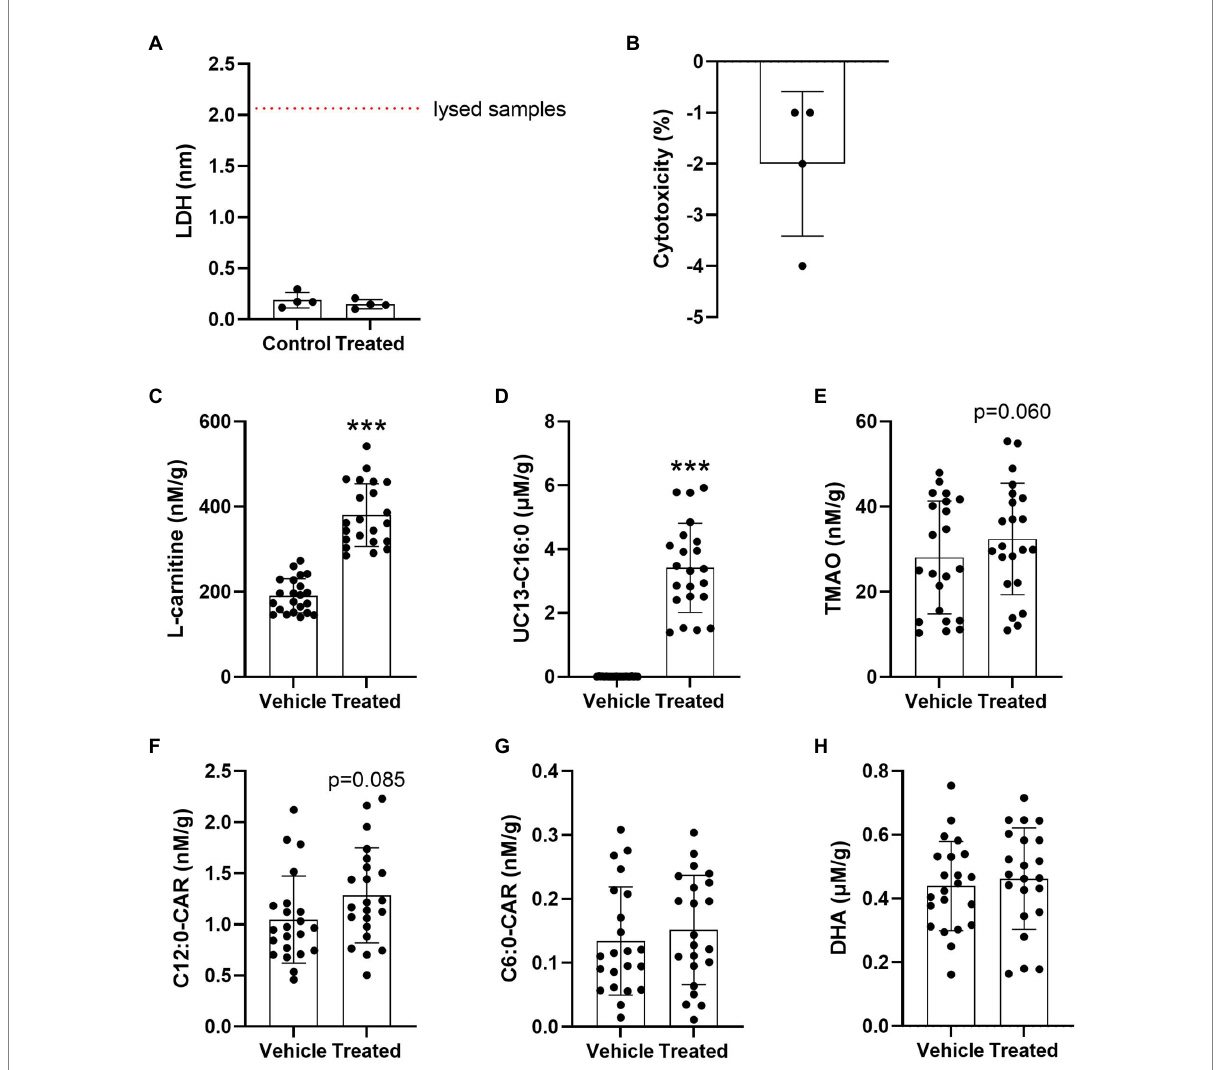
FIGURE 7 Significant cerebrovascular uptake of treatment compounds. (A) Scatterplots with bar showing mean LDH absorbance values in nm in vehicle treated and compound treated cerebrovascular fractions. (B) Scatterplots with bar showing % treatment cytotoxicity ± SD. (C) Scatterplots with bar showing mean concentration of L-carnitine in nM per gram of protein ± SD in vehicle treated and compound treated cerebrovasculature. (D) Scatterplots with bar showing mean concentration of UC13-C16:0 in μ M per gram of protein ± SD in vehicle treated and compound treated cerebrovasculature. (E) Scatterplots with bar showing mean concentration of TMAO in nM per gram of protein ± SD in vehicle treated and compound treated cerebrovasculature. (F) Scatterplots with bar showing mean concentration of C12:0-CAR in nM per gram of protein ± SD in vehicle treated and compound treated cerebrovasculature. (G) Scatterplots with bar showing mean concentration of C6:0-CAR in nM per gram of protein ± SD in vehicle treated and compound treated cerebrovasculature. (H) Scatterplots with bar showing mean concentration of DHA in μ M per gram of protein ± SD in vehicle treated and compound treated cerebrovasculature. Statistics: related-samples analysis, *** p < 0.001. Numbers per group: matched control-treated cerebrovascular sample pairs n = 4 per group for LDH test. Matched control-treated cerebrovascular sample pair n = 22 per group for the uptake study. Cx:y-CAR, acylcarnitines; DHA, docosahexaenoic acid; LDH, lactate dehydrogenase; TMAO, trimethylamine- n-oxide; UC13-C16:0, uniformly C13-labeled palmitic